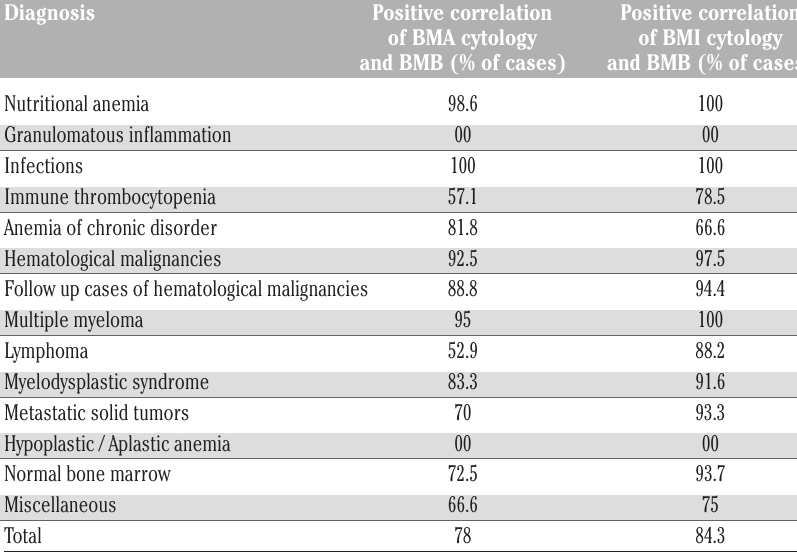
Table 2. Cases showing positive correlation of bone marrow aspirate cytology and imprint cytology with trephine biopsy.